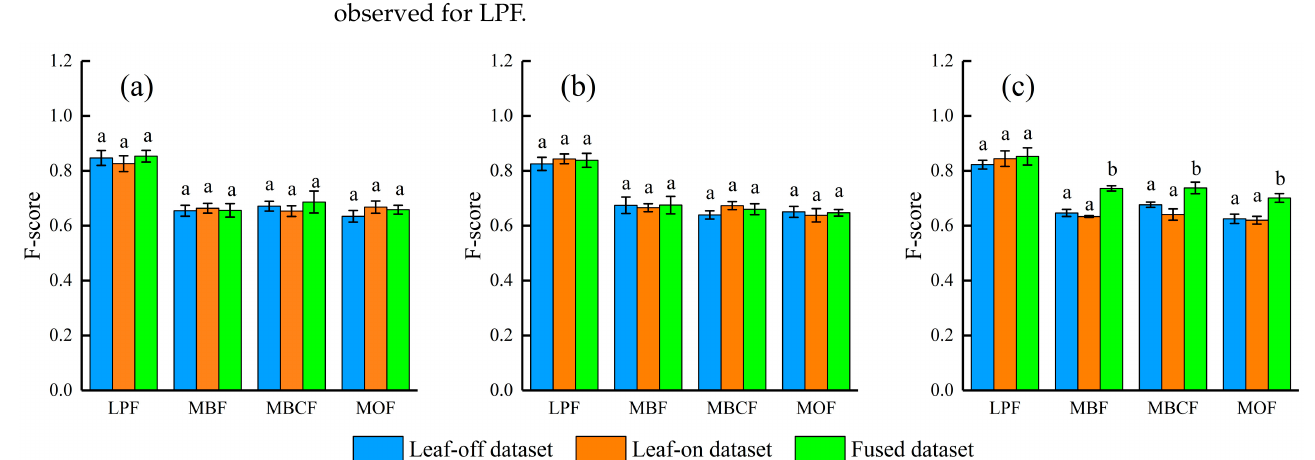
observed for LPF.